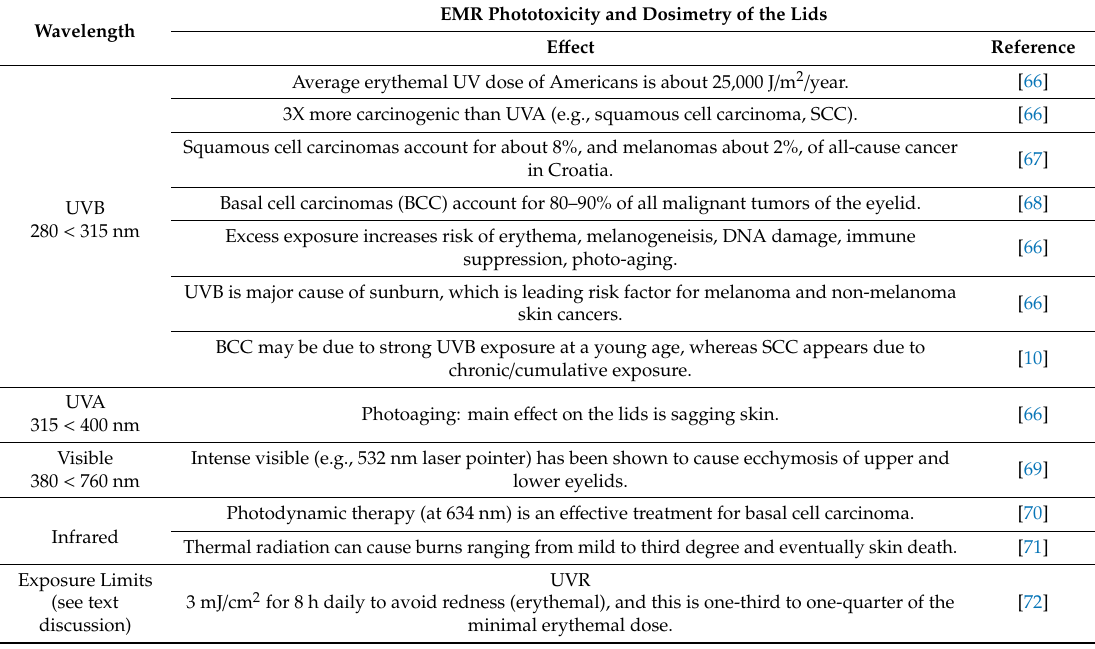
Table 1. Electromagnetic radiation action spectra and dosimetry thresholds for the lids. EMR Phototoxicity and Dosimetry of the Lids Wavelength E ff ect